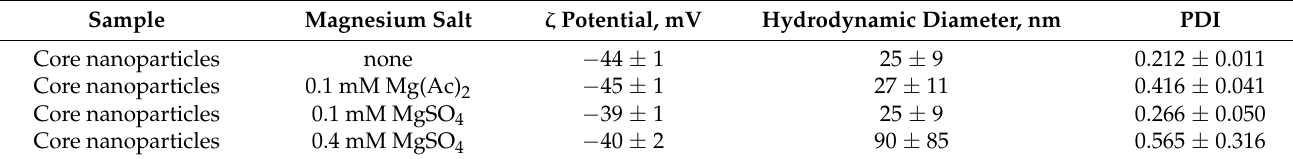
Table 2. Physicochemical characteristics of the core nanoparticles in phosphate buffer containing different magnesium salts.